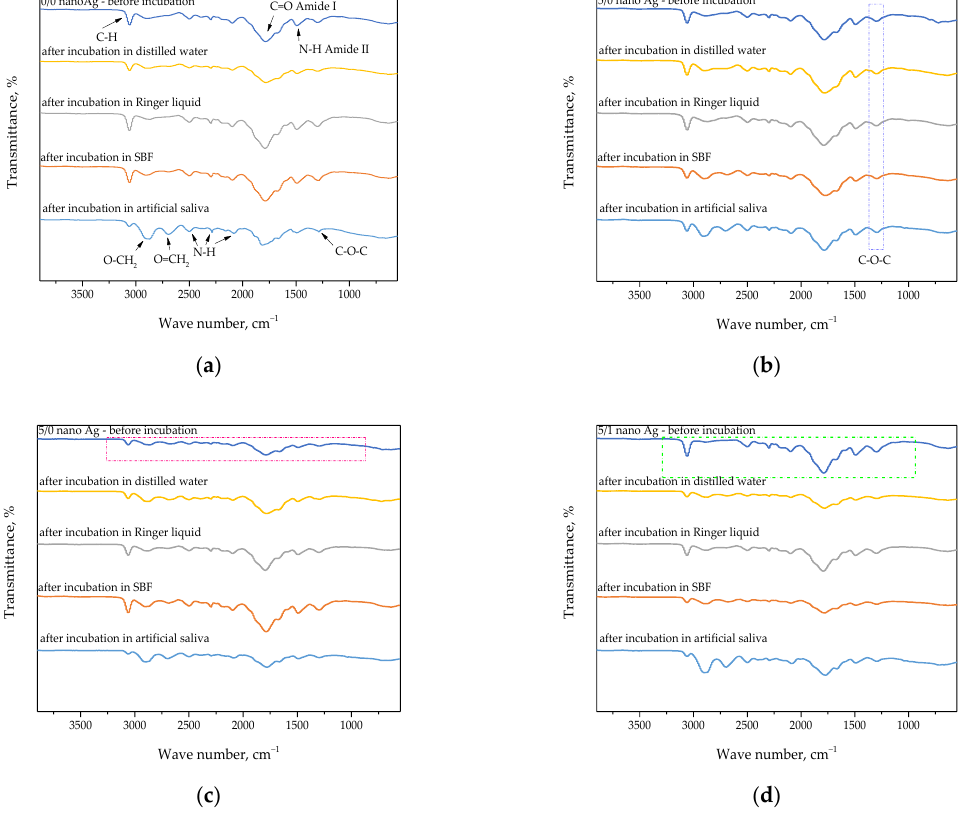
Figure 8. FT-IR spectra showing the impact of the incubation on the structure of sample 0/0 nanoAg ( a ), 5/0 nanoAg ( b ), 0/1 nanoAg ( c ), and 5/1 nanoAg ( d